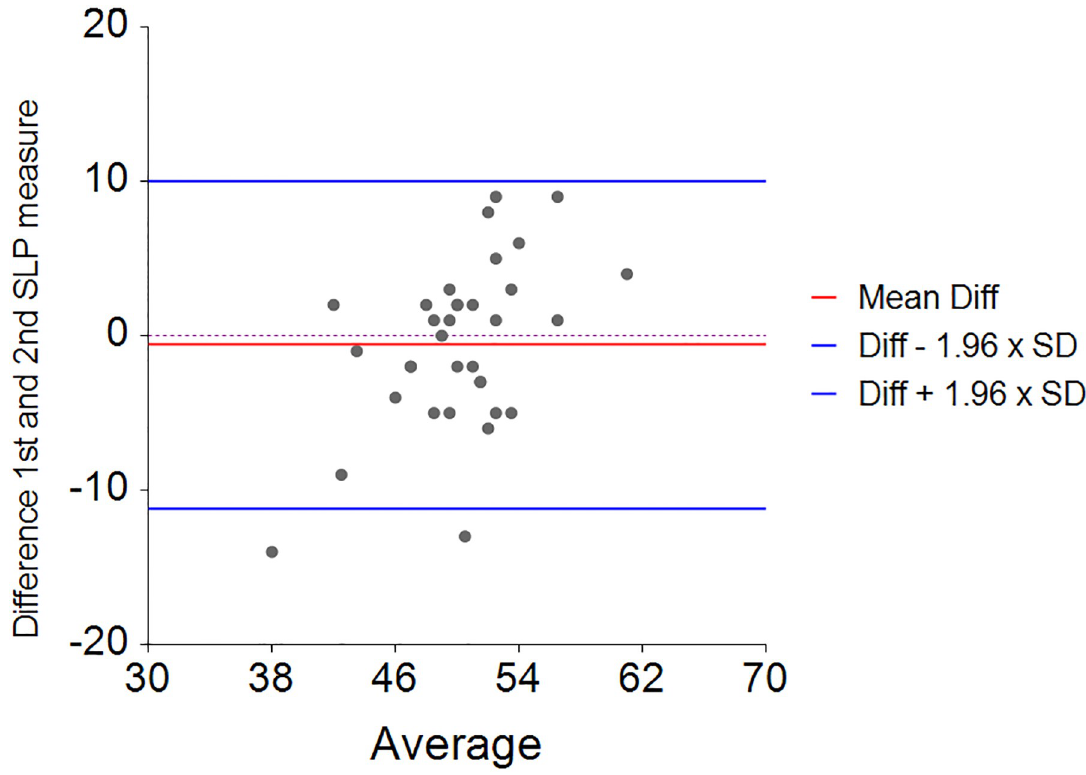
Fig 7. Bland and Altman repeatability plot of tidal breathing (SLP) differences 1st and 2nd measures for maximal expanding side (%) and the average for the patient group.